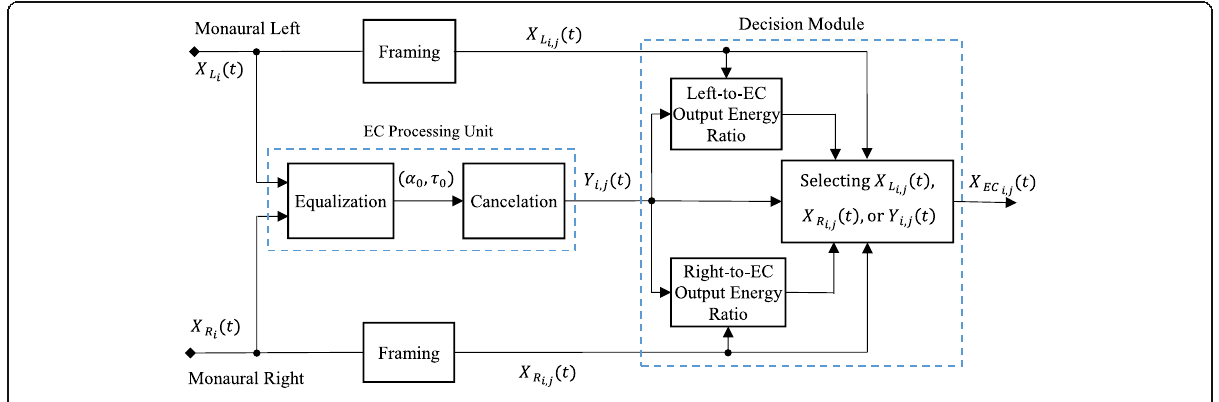
Fig. 4 The block diagram of the binaural EC-based model